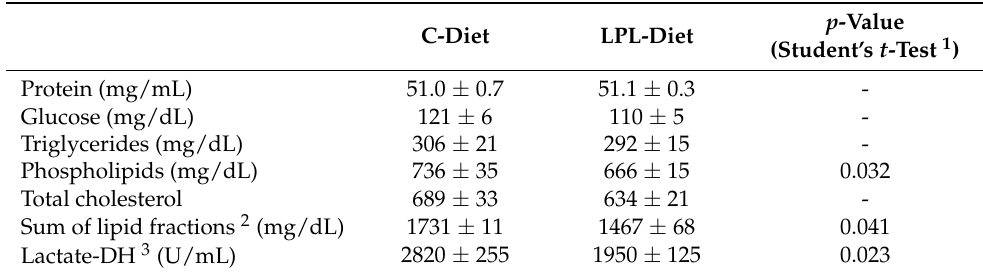
Table 2. Plasma metabolites of Atlantic salmon fed with control diet (C-diet) and lysophospholipid- enriched diet